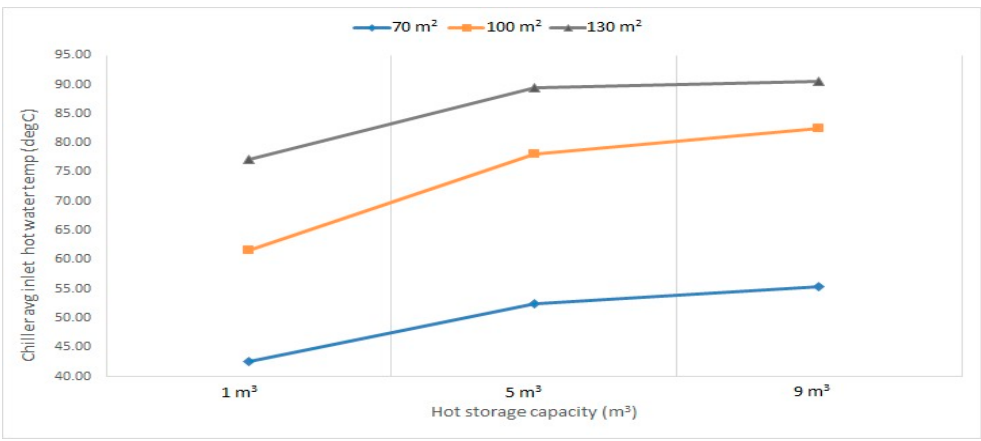
Figure 11. Chiller average inlet hot water temperature at 1 kg/s for different hot storage capacities and solar collector areas (collector–HW tank–chiller) pumps flow rates.